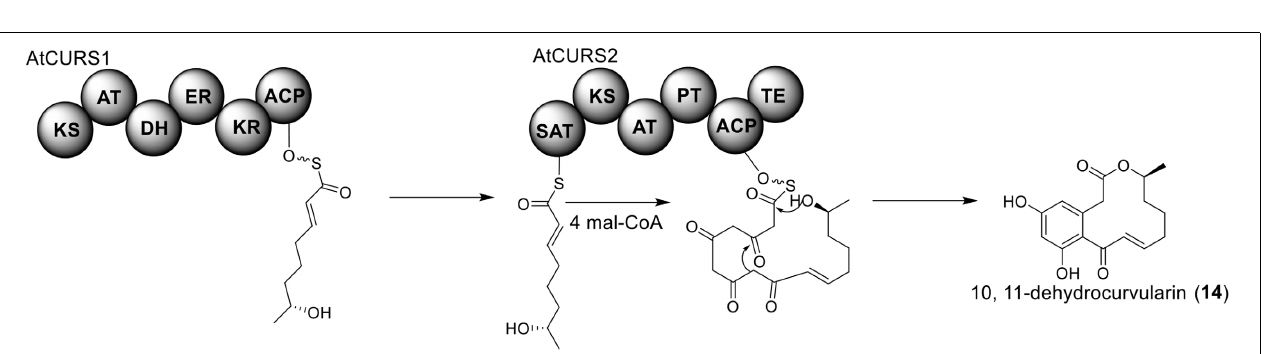
FIGURE 3 | Biosynthesis of terretonin in A. terreus .